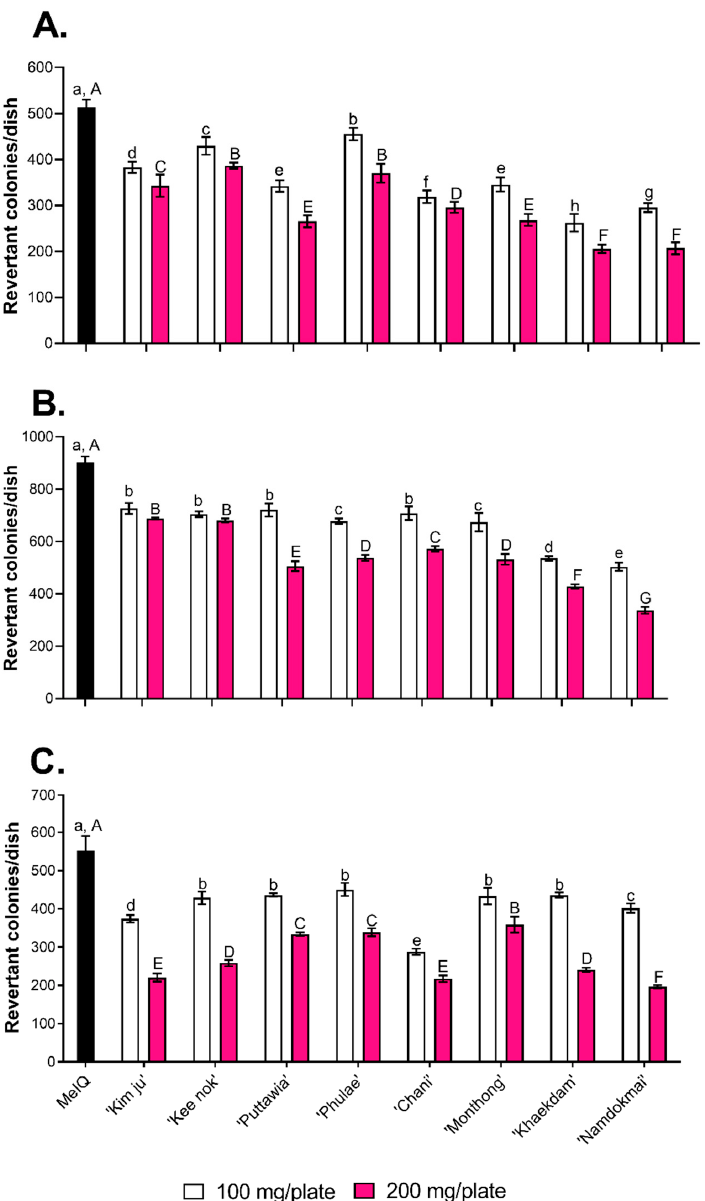
Figure 1. Effect of the eight fruit extracts on inhibition of chemical-mediated DNA mutation deter- mined by TA98 in the presence of S9 mix. ( A ) Inhibition against 3-amino-1,4 dimethyl-5H-pyrido[4,3 b]indole (Trp-P1), ( B ) Inhibition against 3-amino-1-methyl-5H-pyrido[4.3-b]indole (Trp-P2), and ( C ) Inhibition against 2-amino-3,4-dimethylimidazo[4,5-ƒ]quinoline (MeIQ). Different small letters indicate significant differences ( p < 0.05) among fruit extracts at 100 mg/plate compared to each positive control, while different capital letters indicate significant differences ( p < 0.05) among fruit extracts at 200 mg/plate compared to each positive control. Error bars represent standard deviations (SD) from the four experiments.